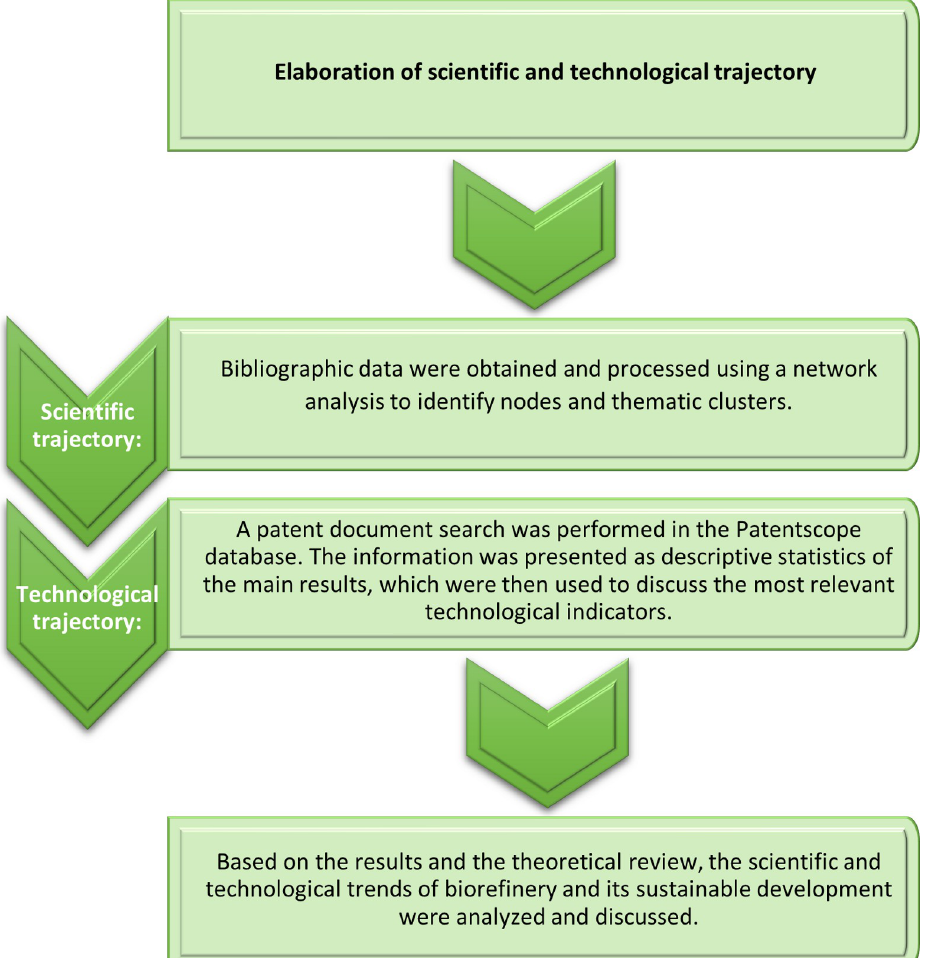
Fig 1. Methodological sequence. Source: Elaborated by the